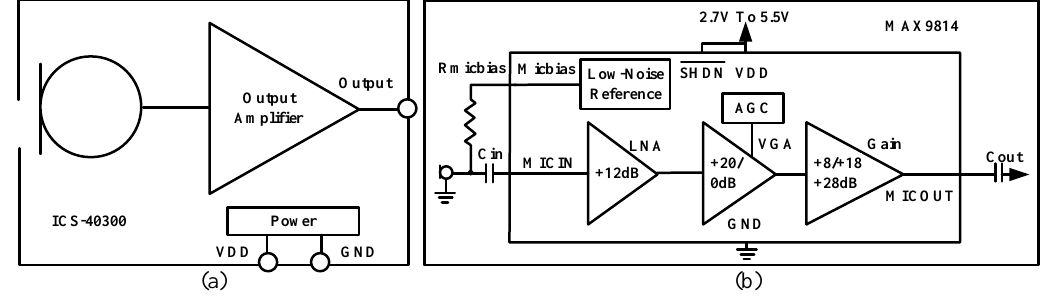
Figure 2. Schematics of ( a ) ICS-40300 and ( b ) MAX9814.